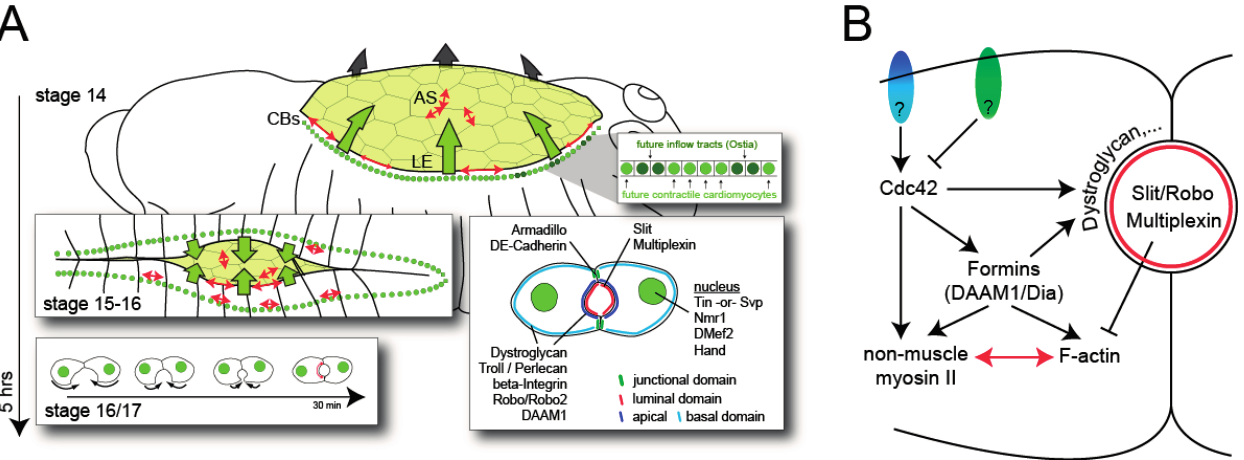
Figure 1. ( a ) Overview of Drosophila heart morphogenesis. Cardioblasts (CBs, green circles) collectively migrate towards the dorsal midline of the embryo. These differentiate later into contractile cardiomyocytes (light green) and ostia cells (dark green). Actomyosin activity can be detected at the edge of the cells of the amnioserosa (AS), at the leading edge of the epidermis (LE) and at the apical side of CBs (red arrows indicate the axis of actomyosin bundles). CB migration is completed within 5 h. Epithelial closure precedes heart closure, and once the CBs make first contact at Stage 16, within 30 min, they actively enclose a central lumen. At that stage, several compartments within the CBs can be identified using several different markers. ( b ) Model showing genetic interactions between Cdc42, formins, actomyosin and the luminal proteins, Slit and Multiplexin. The upstream regulators of Cdc42 (both positive and negative) are yet to be